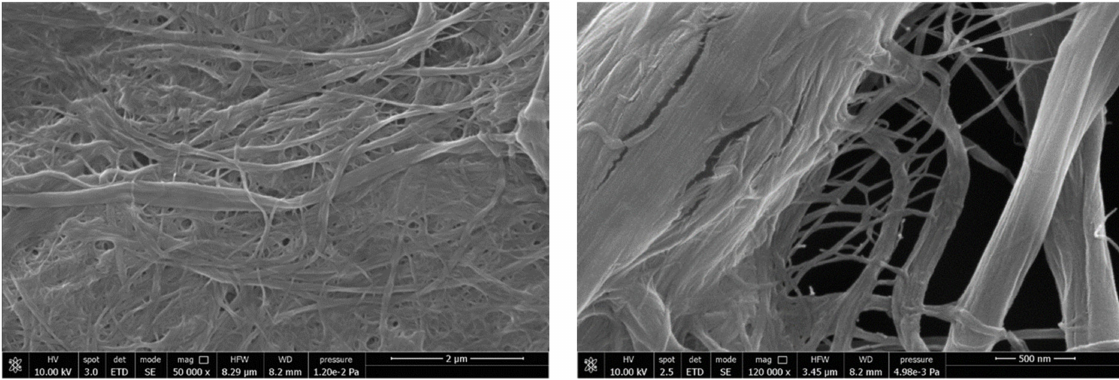
Figure 5. Morphology of the Exilva–MFC